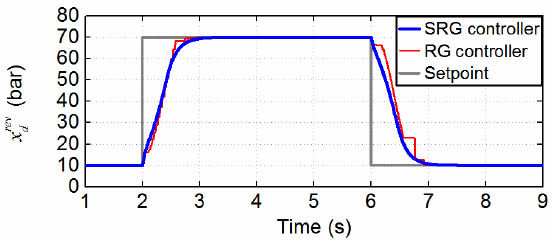
Figure 8. Trajectory used for the nonlinear DOB controller of the three controllers.